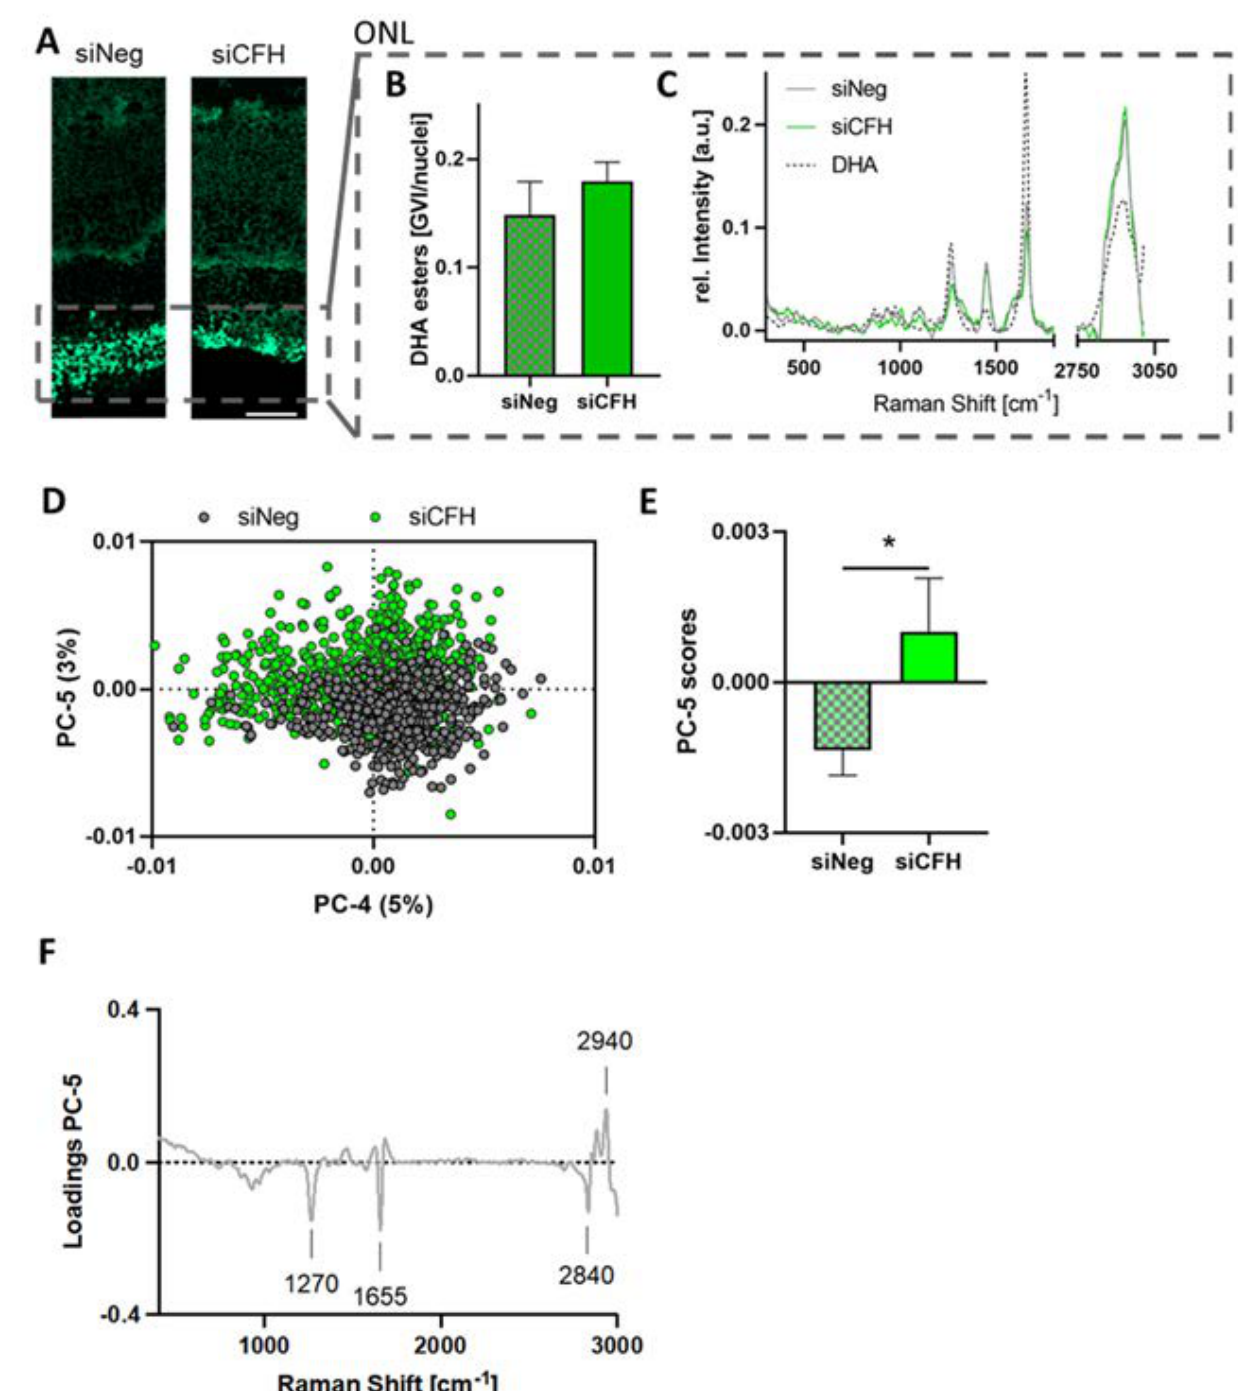
Figure 4. ( A ) TCA intensity distribution heatmaps of the first lipid feature showed a dominant localization in the ONL region. ( B ) Quantification of lipid signal/cell in the ONL. ( C ) Overlay of a DHA reference spectrum (black, dashed) with the average siCFH (green) and siNeg (gray) spectra from the lipids in the ONL region. ( D – F ) Principal component analysis (PCA) of single spectra ( n = 100 per sample) extracted from siNeg (gray) and siCFH (green) ONL regions demonstrates a clustering in the PCA scores plot ( D ) with a significant difference described by PC-5 ( E ). The most relevant spectral signatures are demonstrated in the loadings plot ( F ). Data are represented as mean ± SD, n = 3, * p ≤ 0.05, scale bar—50 µ